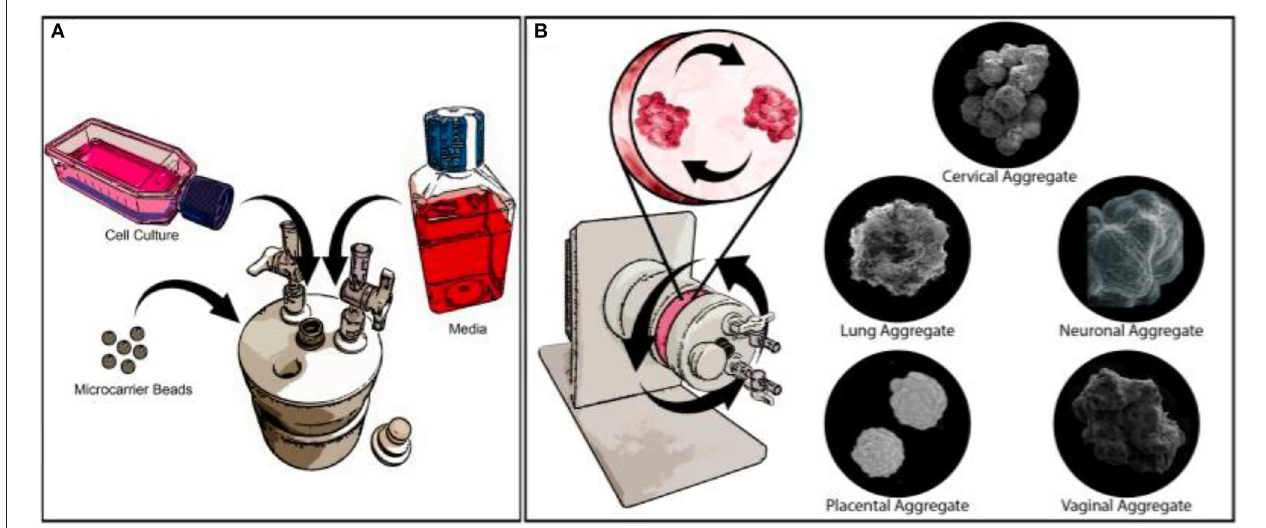
FIGURE 3 | The RWV bioreactor used to engineer 3D tissues for the co-culture of human broncho-tracheal cell lines and human broncho-epithelial cells. (A) Confluent cells grown in 2D are combined with media and microcarrier beads in the bioreactor (B) The RWV was used in other studies to form tissue aggregates. It is kept in continuous rotation to prevent detachment and accumulation of cells at the bottom of the bioreactor. This figure is reprinted under the terms of the Creative Commons Attribution License from Gardner and Herbst-Kralovetz (2016).